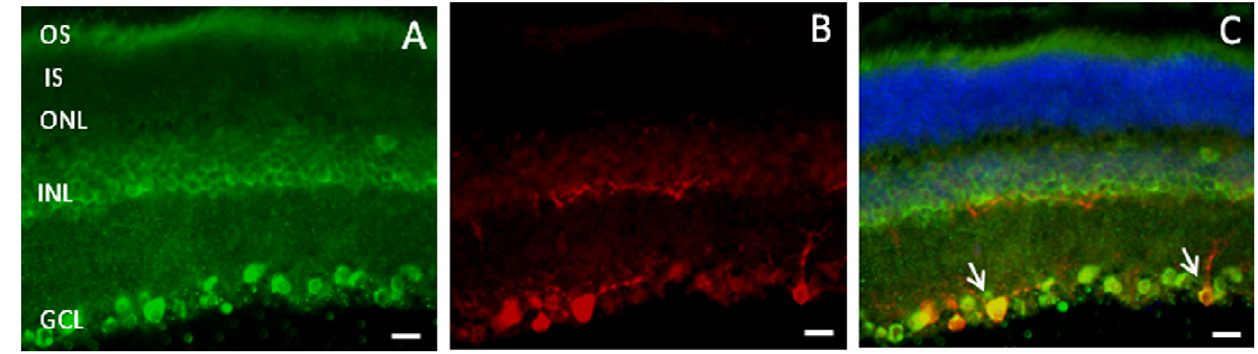
Figure 3. MT 1 receptor immunoreactivity in ip RGCs cells. The co-localization of MT 1 receptor with melanopsin immunoreactivity on ip RGCs is evident in panel C (white arrows) where the images have been merged. (A=MT 1 ; B=melanopsin; C=merge). The bars at the bottom of the Figures represent 15 m m. Micrographs are representative of results obtained from at least three mice.